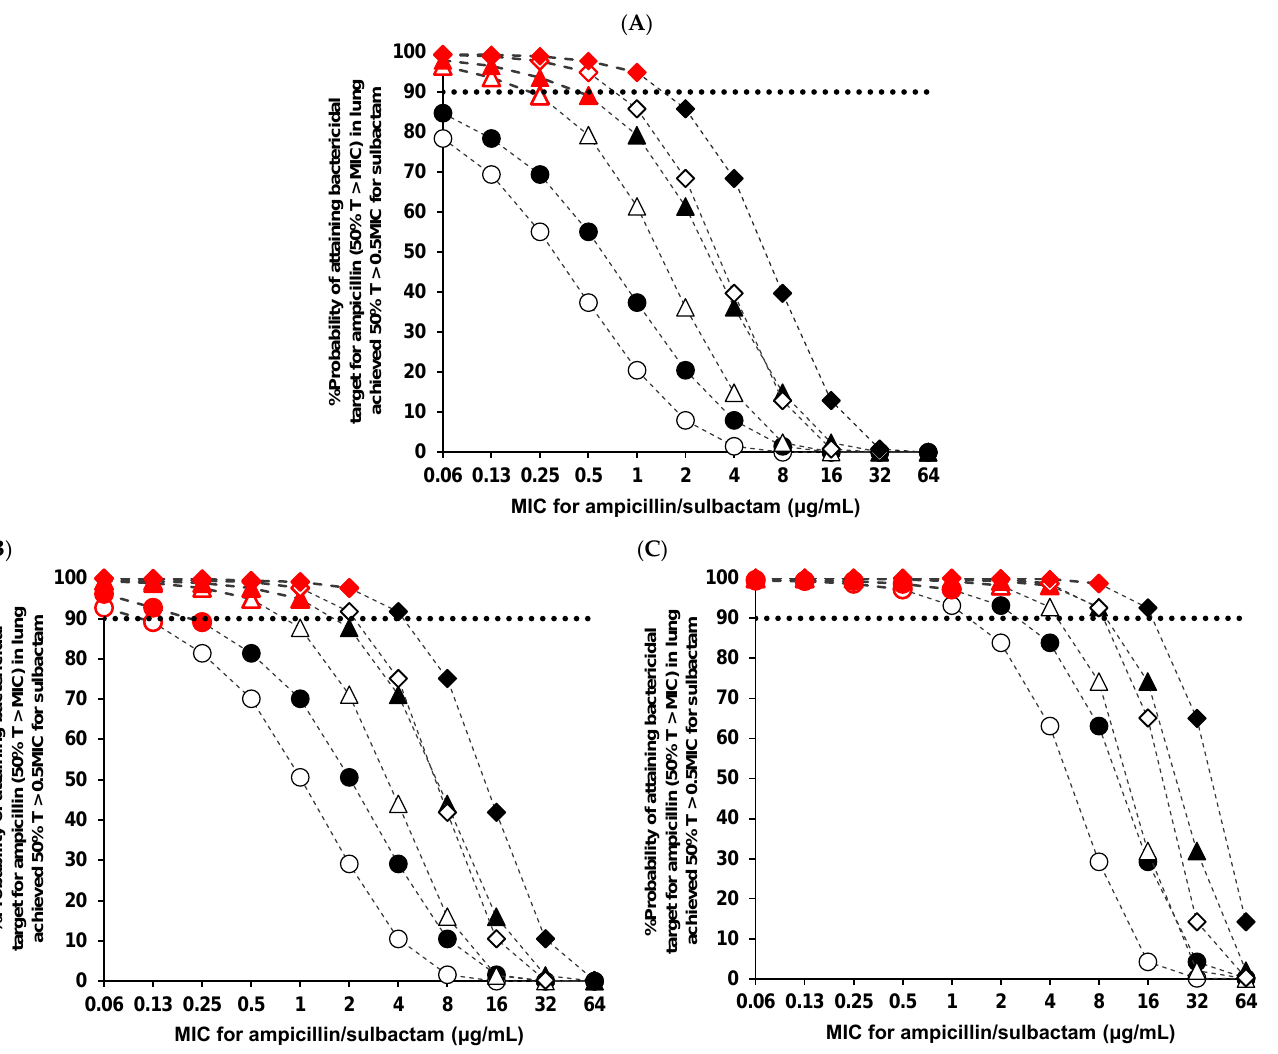
Figure 2. Probabilities of attaining bactericidal (50% T > MIC for ampicillin) targets in lung tissue at specific MICs for typical patients of ( A ) CL cr = 90 mL/min, ( B ) CL cr = 60 mL/min, and ( C ) CL cr = 30 mL/min, respectively. Regarding the probability – MIC curve for ampicillin in lung tissue, MICs with a probability of target attainment for sulbactam of more than 90% (50% T > 0.5 MIC for sulbactam), indicating that the ampicillin/sulbactam combination is effective, are represented by red symbols. The lines represent the probability of target attainment for each dosing regimen of ampicillin/sulbactam ( 〇 1.5 g twice daily, 0.5-h infusion; ● 3.0 g twice daily, 0.5-h infusion; △ 1.5 g three times daily, 0.5-h infusion; ▲ 3.0 g three times daily, 0.5-h infusion; ◇ 1.5 g four times daily, 0.5-h infusion; ◆ 3.0 g four times daily, 0.5-h infusion). The dotted black line represents a 90% probability. MIC, minimum inhibitory concentration.